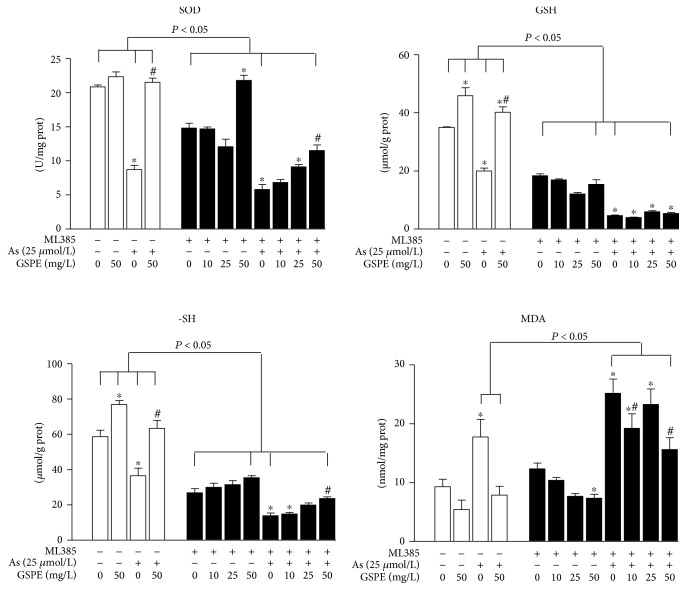
Effects of arsenic and/or grape seed procyanidin extract on oxidative stress after Nrf2 inhibition. After Nrf2 inhibition, L-02 cells were treated with arsenic and/or grape seed procyanidin extract for 24 h. ∗Compared with the control group, P < 0.05; #compared with the arsenic group, P < 0.05. 50 mg/L GSPE could increase SOD activity and reduce MDA level compared with the control group. SOD, GSH, and -SH levels in the arsenic group decreased further after Nrf2 inhibition when compared with the control group and were lower than those in the arsenic group before Nrf2 inhibition. MDA content increased further after Nrf2 inhibition and was higher than that in the arsenic group before Nrf2 inhibition. SOD and -SH levels in the arsenic + GSPE group increased after Nrf2 inhibition compared with the levels in the arsenic group, but were still lower than the levels in the arsenic + GSPE group before Nrf2 inhibition.